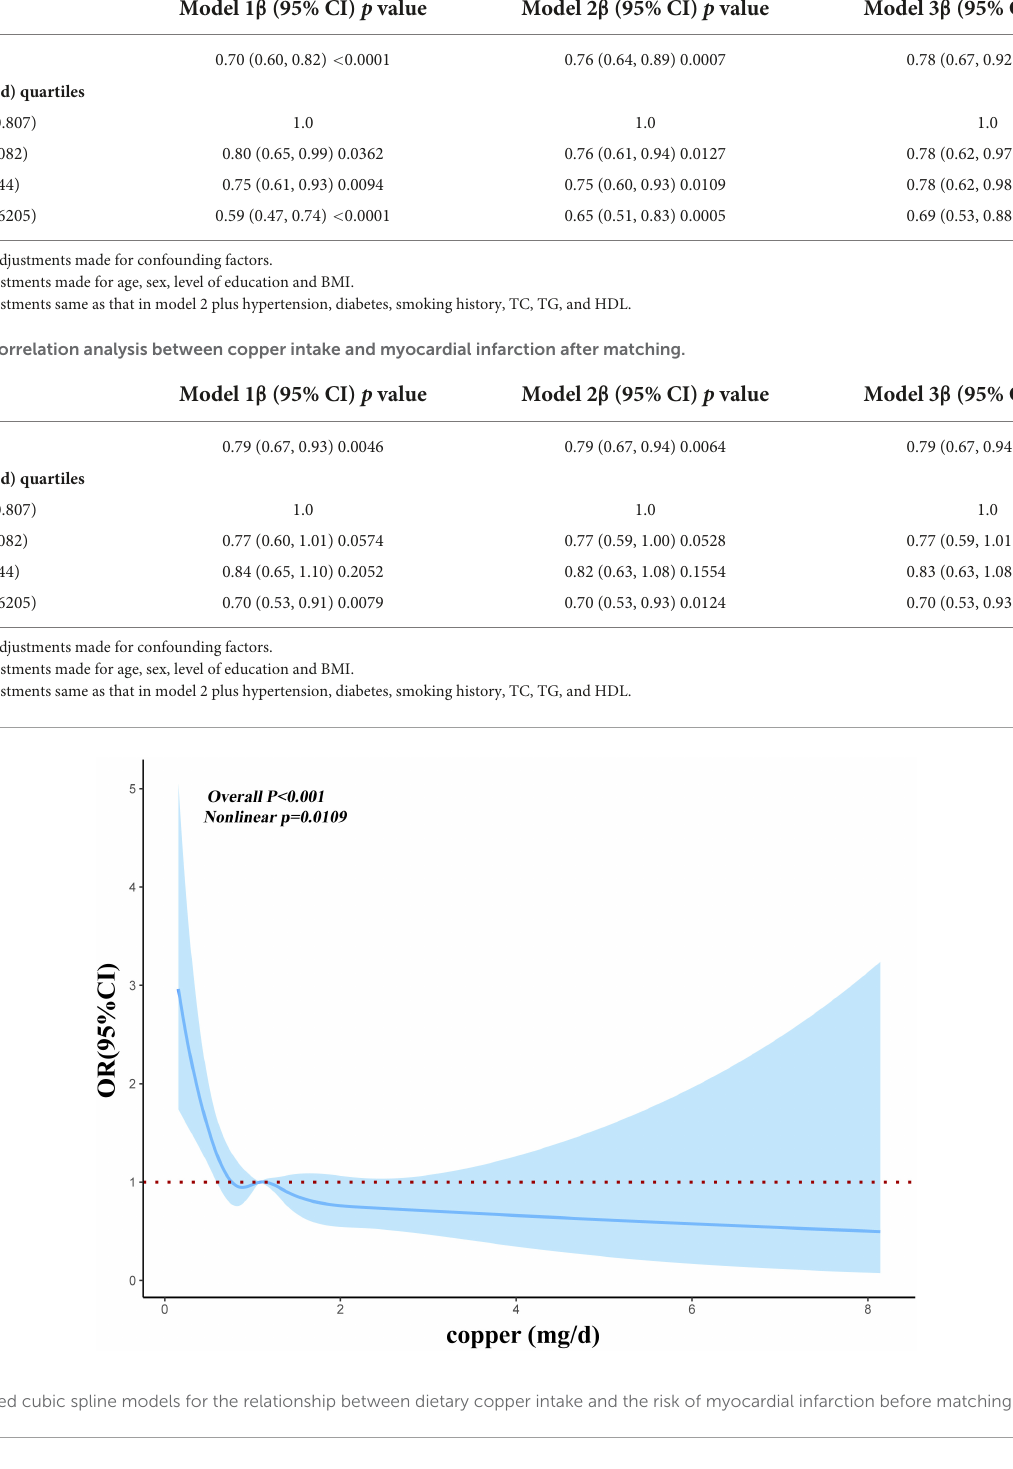
smoking status, hypertension, diabetes, and lipid